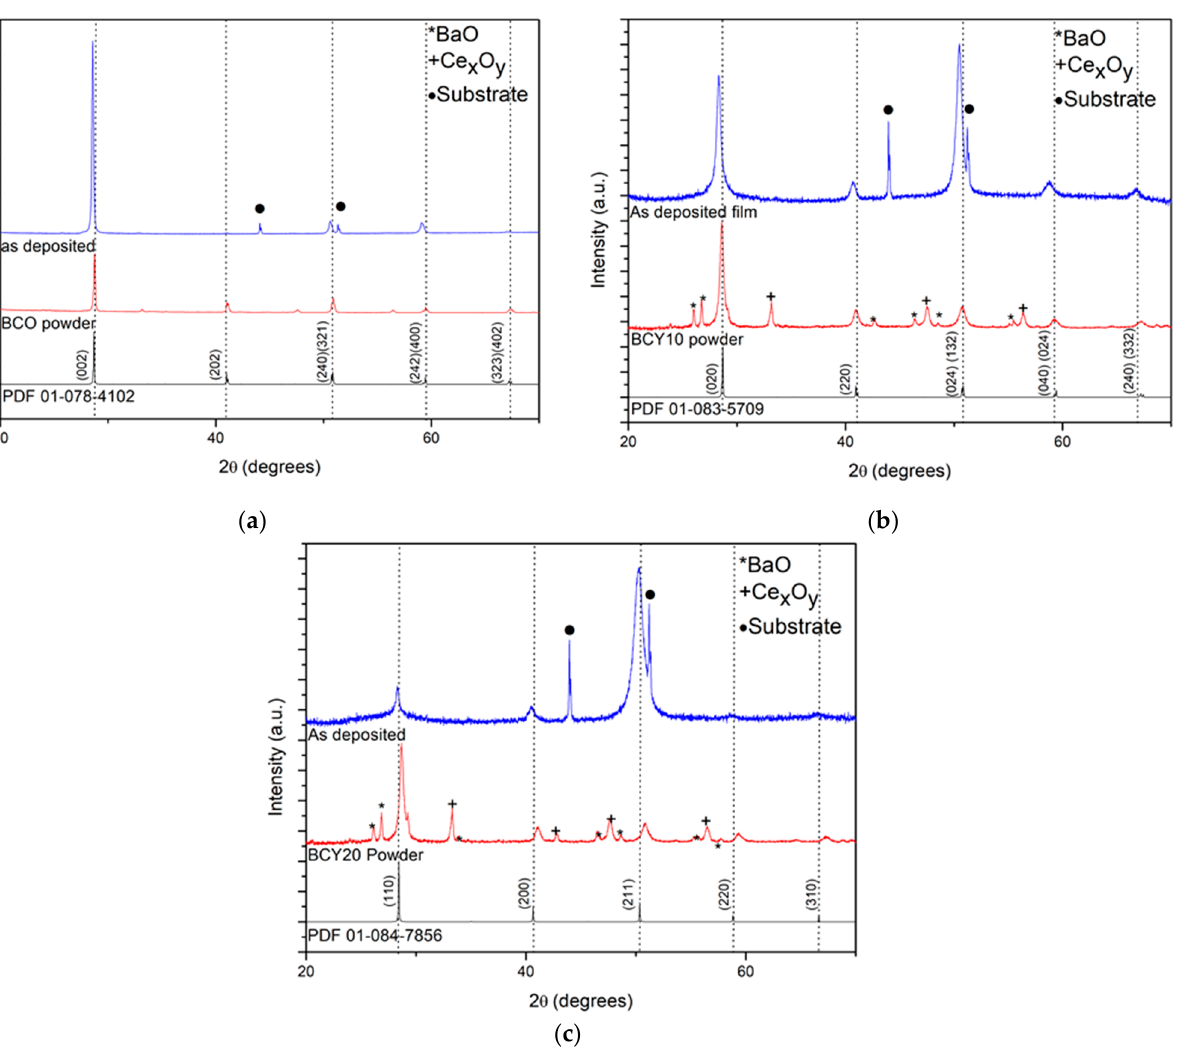
Figure 3. XRD patterns of ( a ) BCO thin films and initial powder; ( b ) BCY10 thin films and initial powders; and ( c ) BCY20 thin films and initial powder.